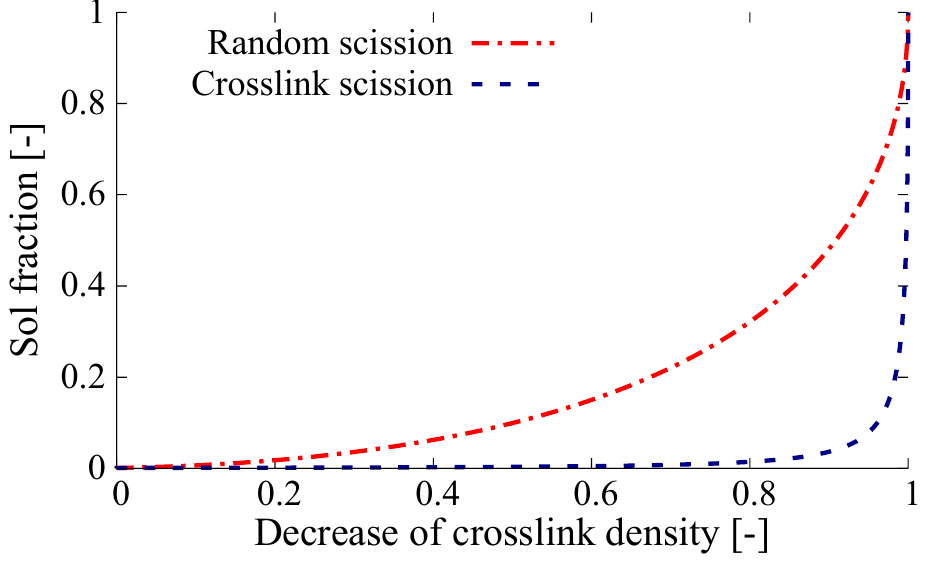
Figure 1. A typical Horikx-Verbruggen